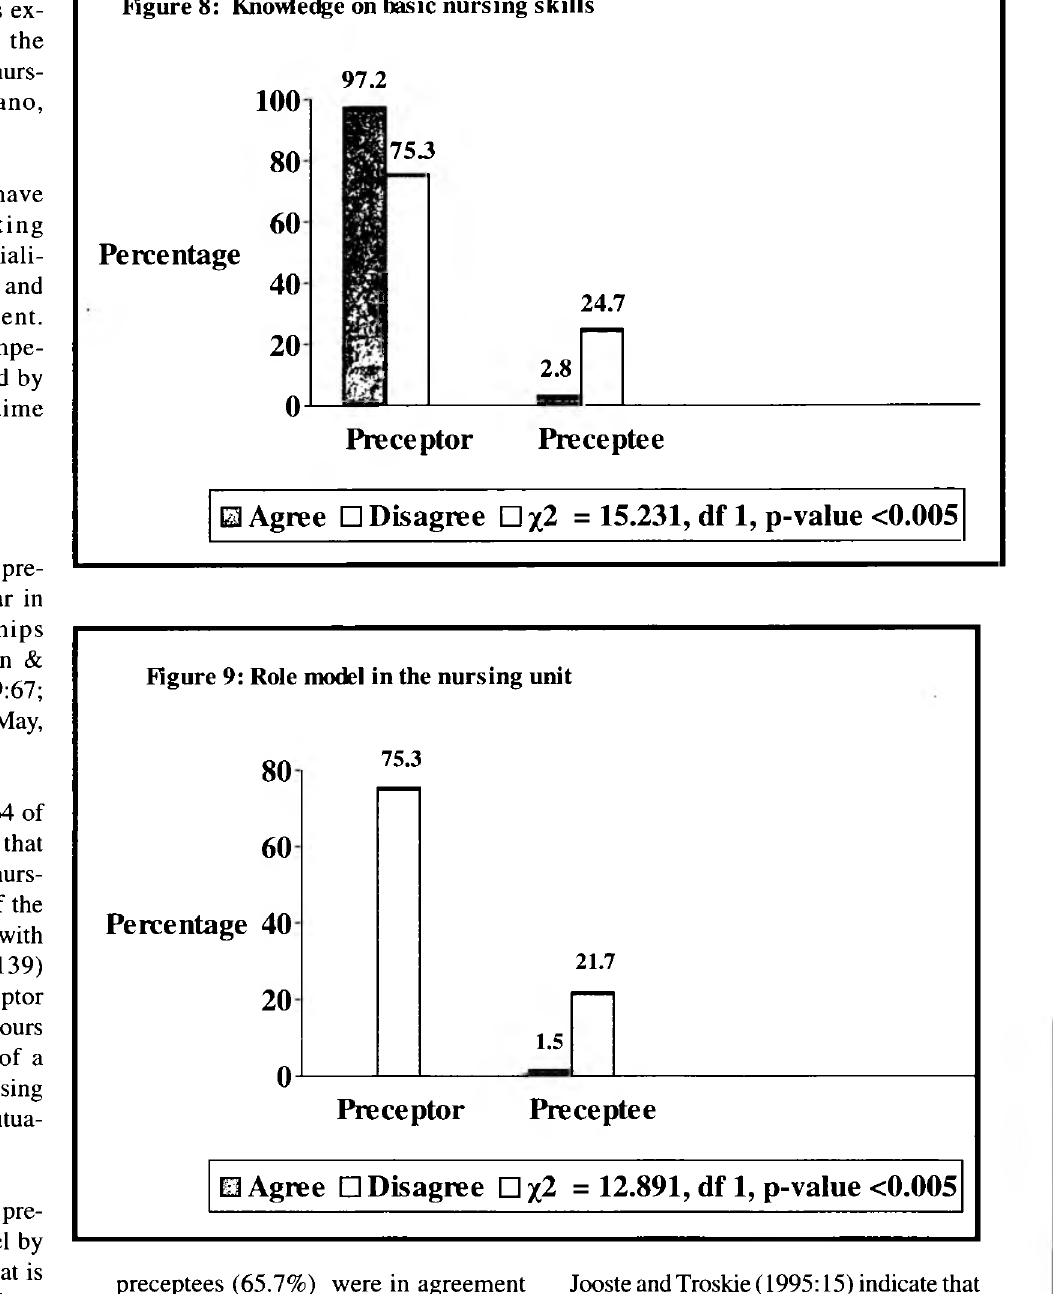
Figure 9: Role model in the nursing